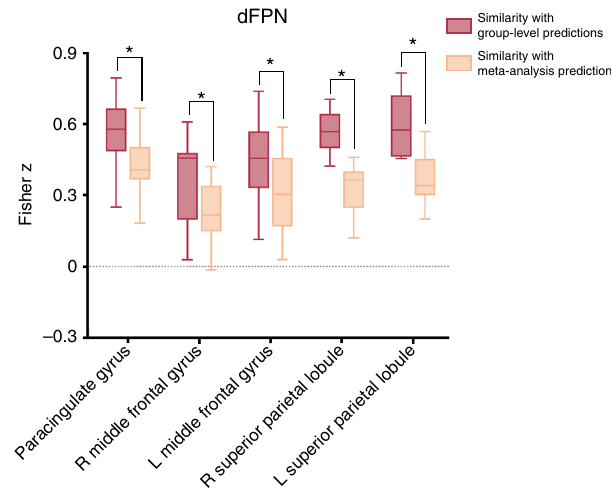
Fig. 4 Post-hoc cluster-based comparison with meta-analysis. In order to statistically assess differences between our obtained group-level Bayesian predictions from Experiment 1 and the, according to the meta-analysis, hypothesized predictions across the whole task space, we compared two different post-hoc whole-brain back-projections (see Methods section — Post-hoc cluster-based comparison with meta-analysis). Asterisks (*) indicate signi fi cant fi ndings ( p < 0.05) after correcting for multiple comparisons using permutation testing (critical t (9) = 2.81). We found that for each cluster within the dFPN the obtained group-level results were signi fi cantly more likely than the hypothesized predictions. On each box, the central mark is the median, the edges of the box are the 25th and 75th percentiles, the whiskers extend to the most extreme datapoints considered not to be